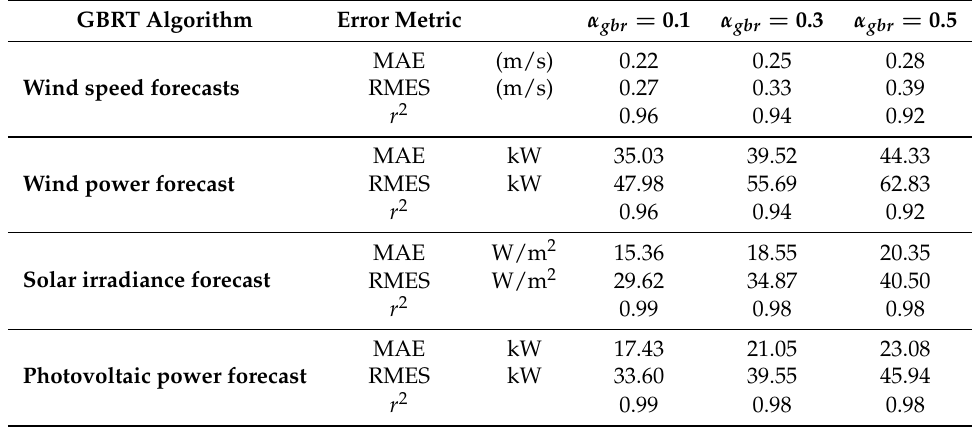
Table 5. Forecasting results of GBRT model based on MAE, RSME and r 2 considering three α gbr values: α gbr = { 0.1, 0.3, 0.5 }.